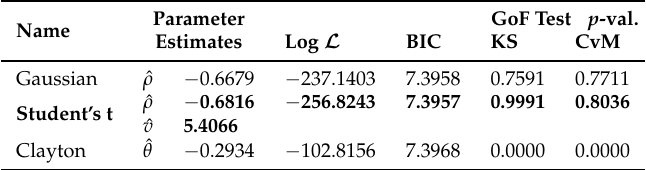
Table 4. Estimates, log likelihoods, BIC and p-values of the KS- and CvM tests for different copula families estimated on standardized residuals. The copula with the lowest BIC is marked bold.